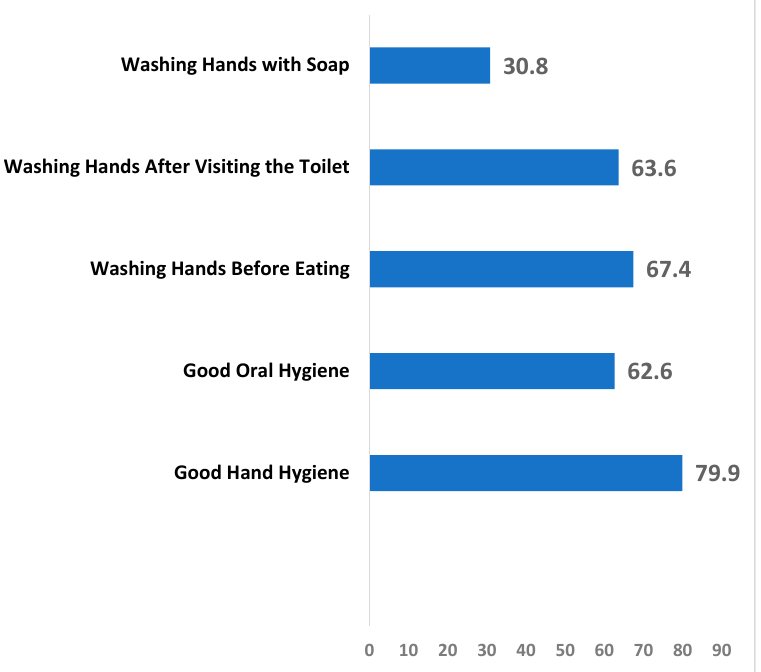
Table 2. Bivariable Relationship between Hygiene Behaviours and the Explanatory Variables.